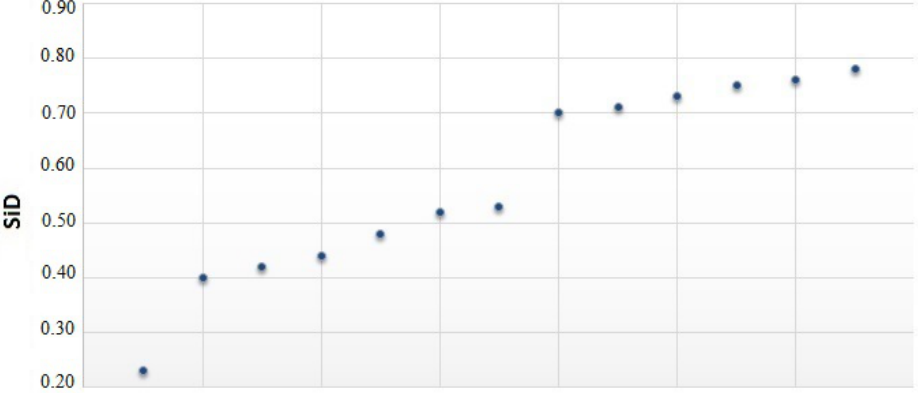
Figure A4. Similarity index (SiD) of SARS-CoV-2, using different host organisms as references. On the horizontal axis, the 13 eukaryotic species that were considered in the comparisons are shown. The host species are ranked in ascending order. CAI values for the bat, rat, hamster, snake, pangolin, and human are higher compared to the other